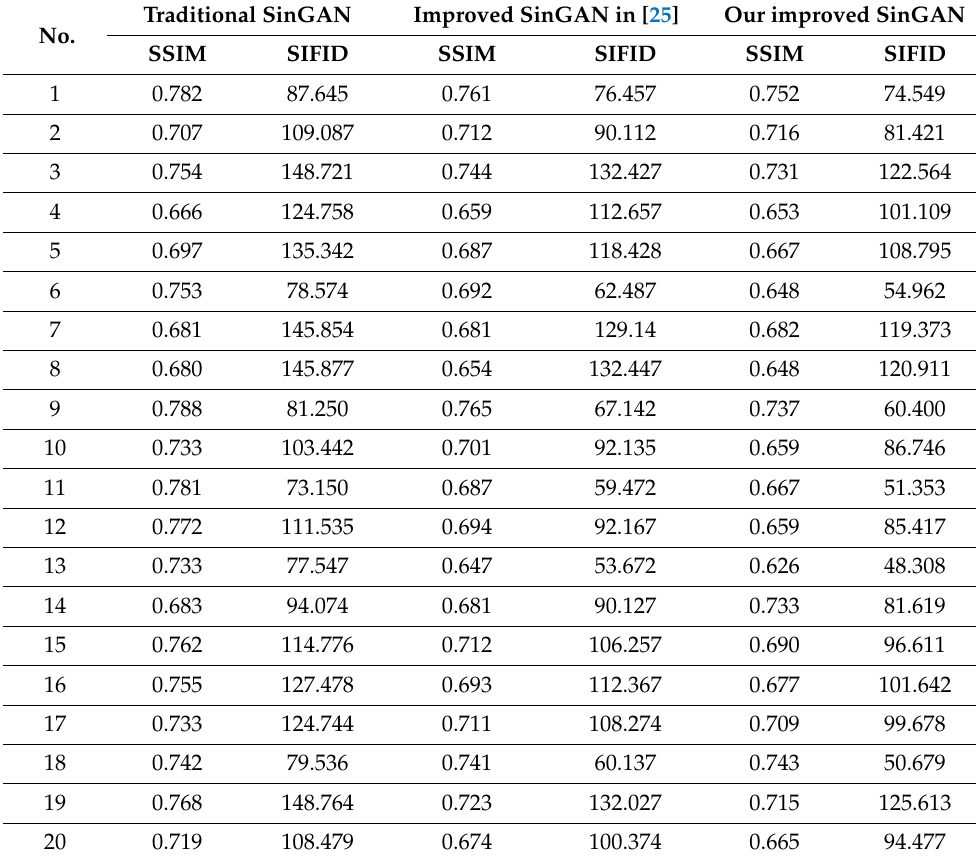
Table 1. Comparison of different SinGAN models in terms of SSIM and SIFID. Traditional SinGAN Improved SinGAN in No.